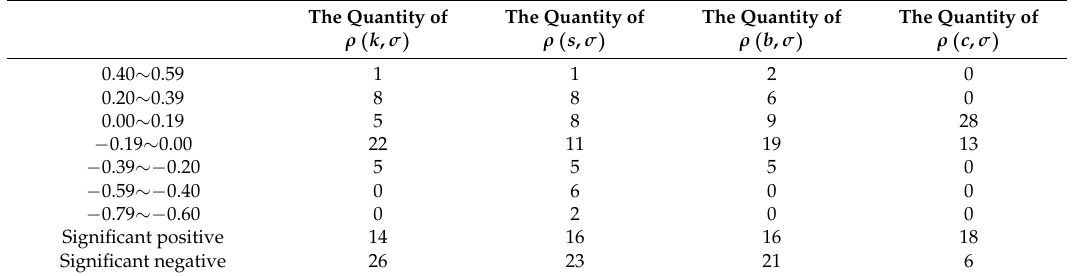
Table 4. Summarize the correlation coefficients between FX volatility and centrality measures.